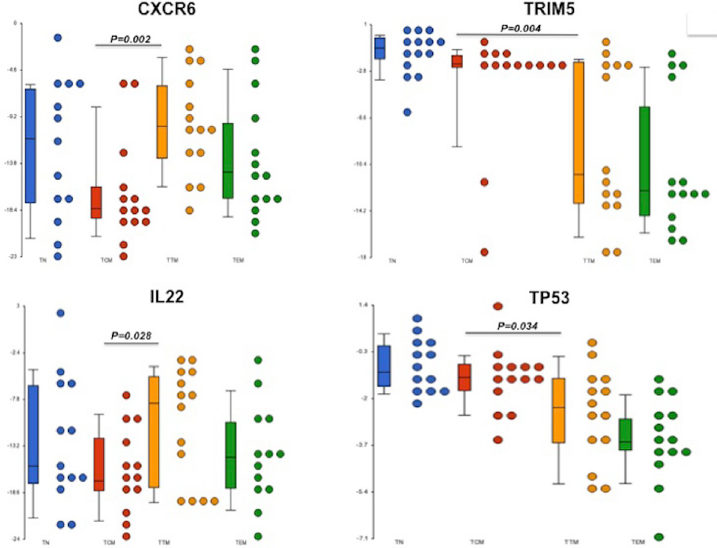
Fig 7. Transcriptomic analysis: A broad multiplex transcriptional profiling analysis of 96 genes was performed in monocytes (CD3-CD4-CD14+) and resting CD4 T-cells subsets: Naive (TN; CD45RA+CCR7+CD27+) central- memory (TCM; CD45RA-CCR7+CD27+) transitional memory (TTM; CD45RA-CCR7-CD27+) and effector- memory cells (TEM; CD45RA-CCR7-CD27-) from 14 HIV-2 infected subjects. The relative expression of CXCR6, TRIM5, IL22 and TP53 in resting CD4 T-cells subsets. A two-tailed Wilcoxon matched-pairs signed rank test was used to compare cell subsets frequencies, CXCR6, TRIM5, IL22 and TP53 expression within TCM and TTM.